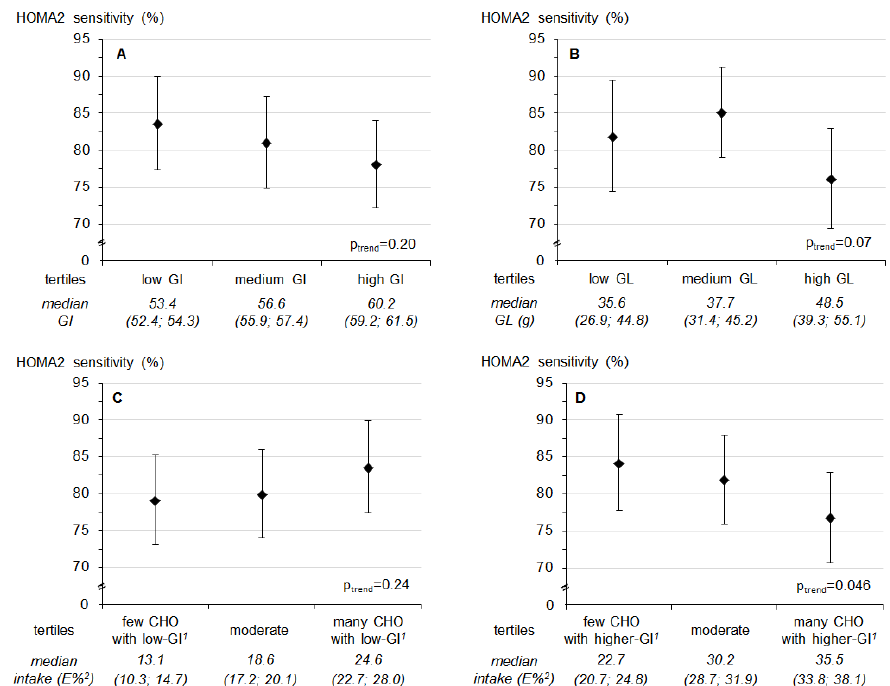
Figure 1. Predicted least square means (95% confidence interval) of HOMA2 sensitivity by tertiles of ( A ) glycemic index (GI) after 6 p.m., ( B ) glycemic load (GL) after 6 p.m., ( C ) intake of low-GI-CHO 1 after 6 p.m. and ( D ) intake of higher-GI-CHO 1 after 6 p.m. Values are least-square means for tertiles obtained from linear regression models. p -values are based on models using the continuous exposure variables. Models were adjusted for first born child (yes/no), baseline BMI-SDS, baseline evening intake of saturated fatty acids and animal protein ( N = 252). Values below the figure refer to median intakes (25th; 75th percentiles) in each tertile of the respective exposure. 1 Distinction between carbohydrate intake from low- and higher-GI food sources with a GI of 55 as cut-off; 2 % of energy intake after 6 p.m. Table 3. Prospective relation of GI and GL of morning (before 11 a.m.) and evening (after 6 p.m.) intake as well as morning and evening intake from low- and higher-GI food sources during adolescence to pro-inflammatory score in young adulthood ( N =